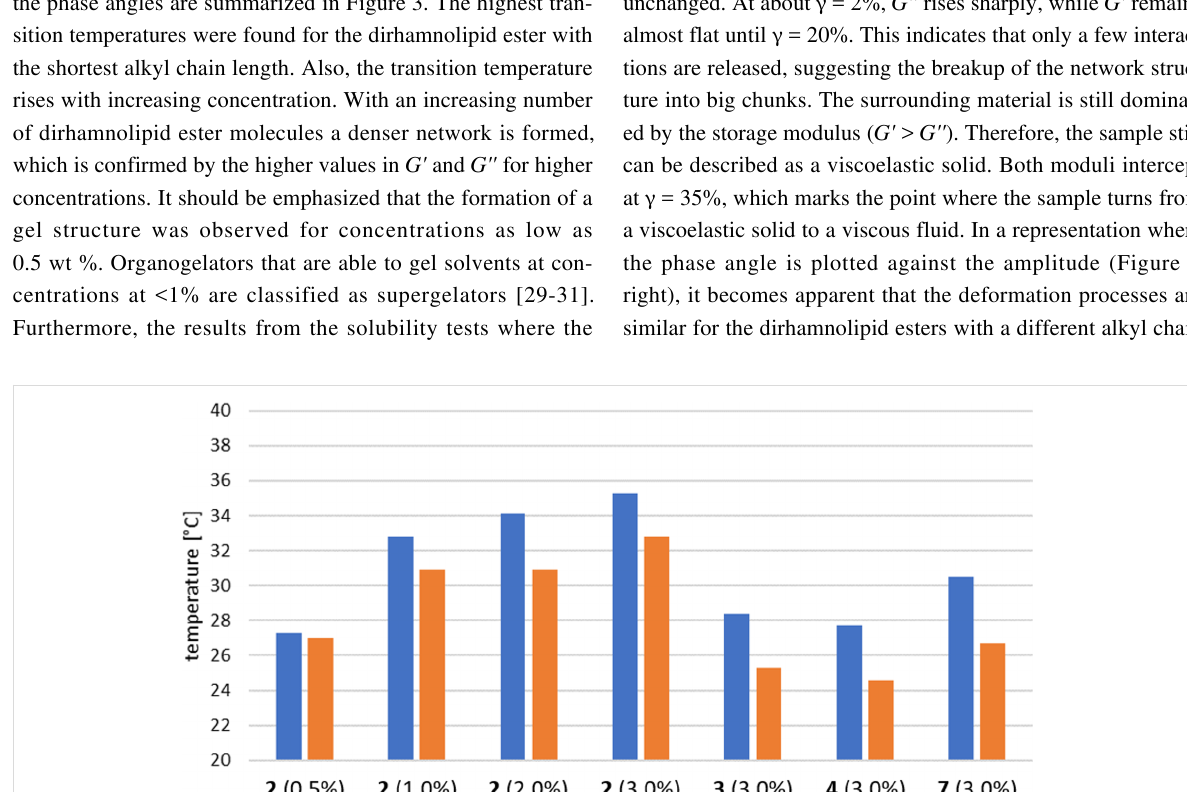
( G'' > G' ). Fluids are unable to store mechanical stress. Thus, the storage modulus drops to almost zero. For the cooling process, the change of the moduli mirrors the ones of the heating process (Figure S1b in Supporting Information File